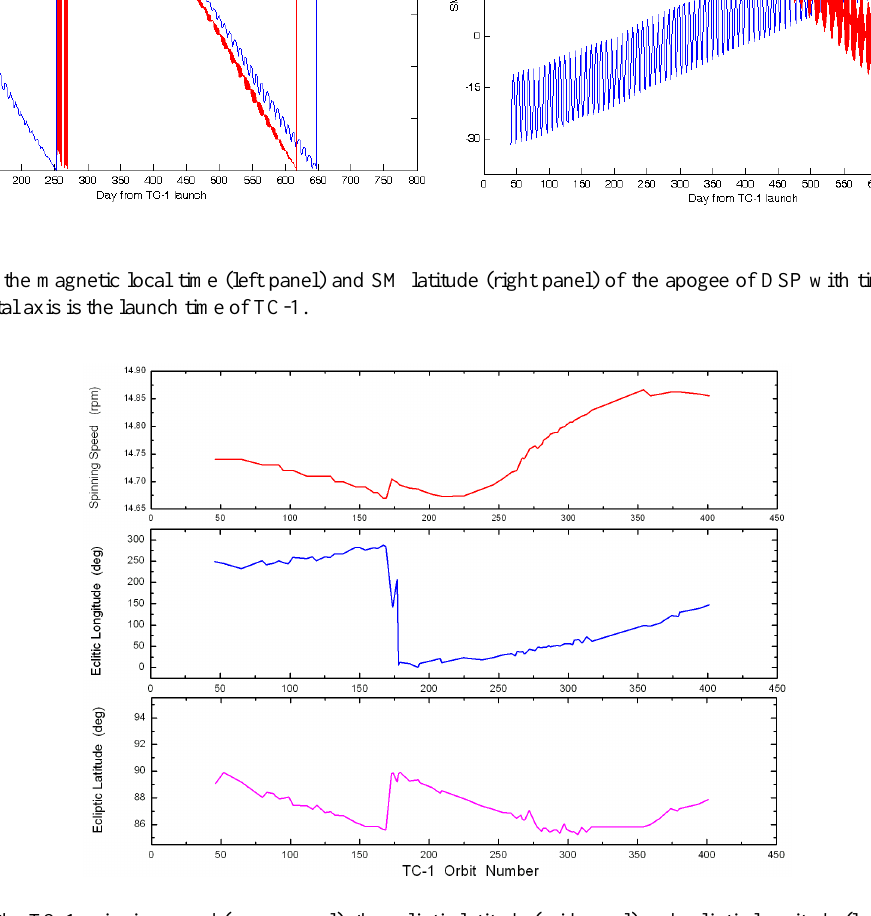
Fig. 3. Evolution of the TC-1 spinning speed (upper panel), the ecliptic latitude (mid panel) and ecliptic longitude (lower panel) of the spin axis of TC-1. Note that the Kepler period of TC-1 is about